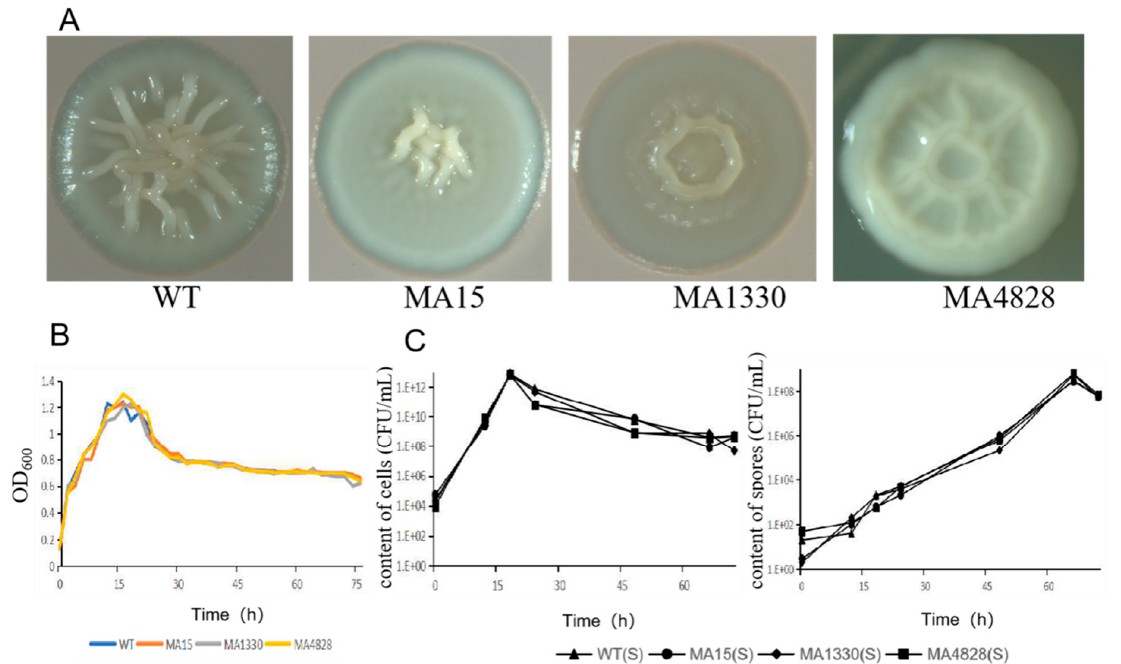
Figure 1. The colony morphology and growth curve of cells and spores. ( A ) The colony morphology of B. pumilus HR10 and biofilm-deficient mutants on LB agar. ( B ) The absorbances of four strains at 600 nm over 72 h. ( C ) The contents of cells (left) and spores (right) of four strains were not significantly different at each testing time.